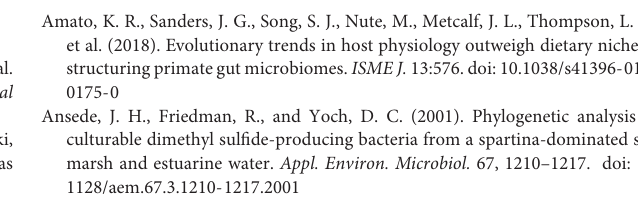
FIGURE S1 | P. margaritifera compartments/tissues. Photo of each of the two shell valves showing, on the right, the collected tissues: GI, the gills; GD, the gonad; BG, the byssus gland; MT, the mantle; AM, the adductor muscle; and GT, the gut (shown partially on the photo). The haemolymph was collected from the byssus using a sterile syringe, while the mucus was collected on the mantle using a sterile swap. FIGURE S2 | Plotted bacterial OTU abundance in core microbiome’s of 0 to 100% of samples of the pearl oyster P. margaritifera . DATA S1 | Overview over sequence counts, taxonomic classification, and 16S rRNA reference amplicon sequence for all 4,085 OTUs. DATA S2 | Overview of significant tissue differences in microbiome composition based on relative abundances of bacterial families, individual OTUs and community diversity and richness. DATA S3 | Similarity percentage (SIMPER) analysis of bacterial community composition associated with different tissues of P. margaritifera . DATA S4 | IndicSpecies analysis of indicator OTUs/bacterial taxa associated with P. margaritifera tissues. DATA S5 | Overview of weighted Nearest Sequenced Taxon Index (NSTI) scores over all oyster samples. DATA S6 | PICRUSt and LEfSe analyses, an overview of differentially abundant KEGG pathways identified in the microbiomes of particular host tissues (per sample data